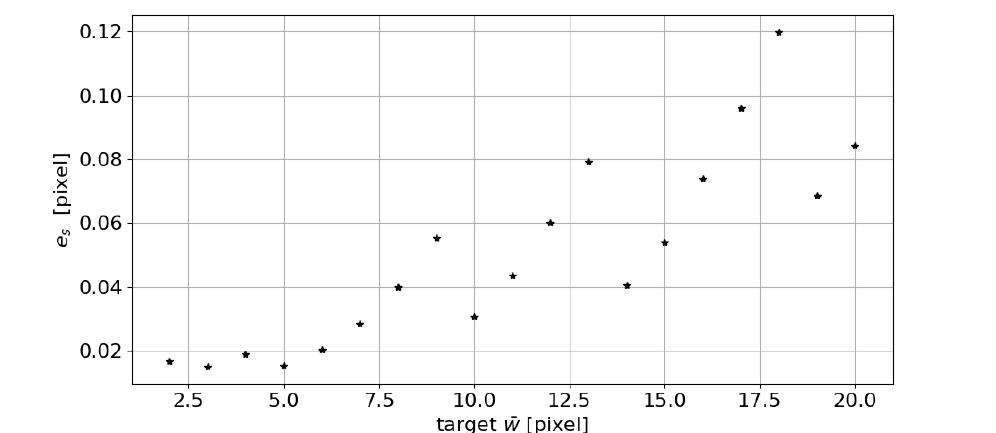
Figure 5. Absolute error trend in the measurement of the line mean width as the asymmetry a changes. (a.u.: arbitrary unit).